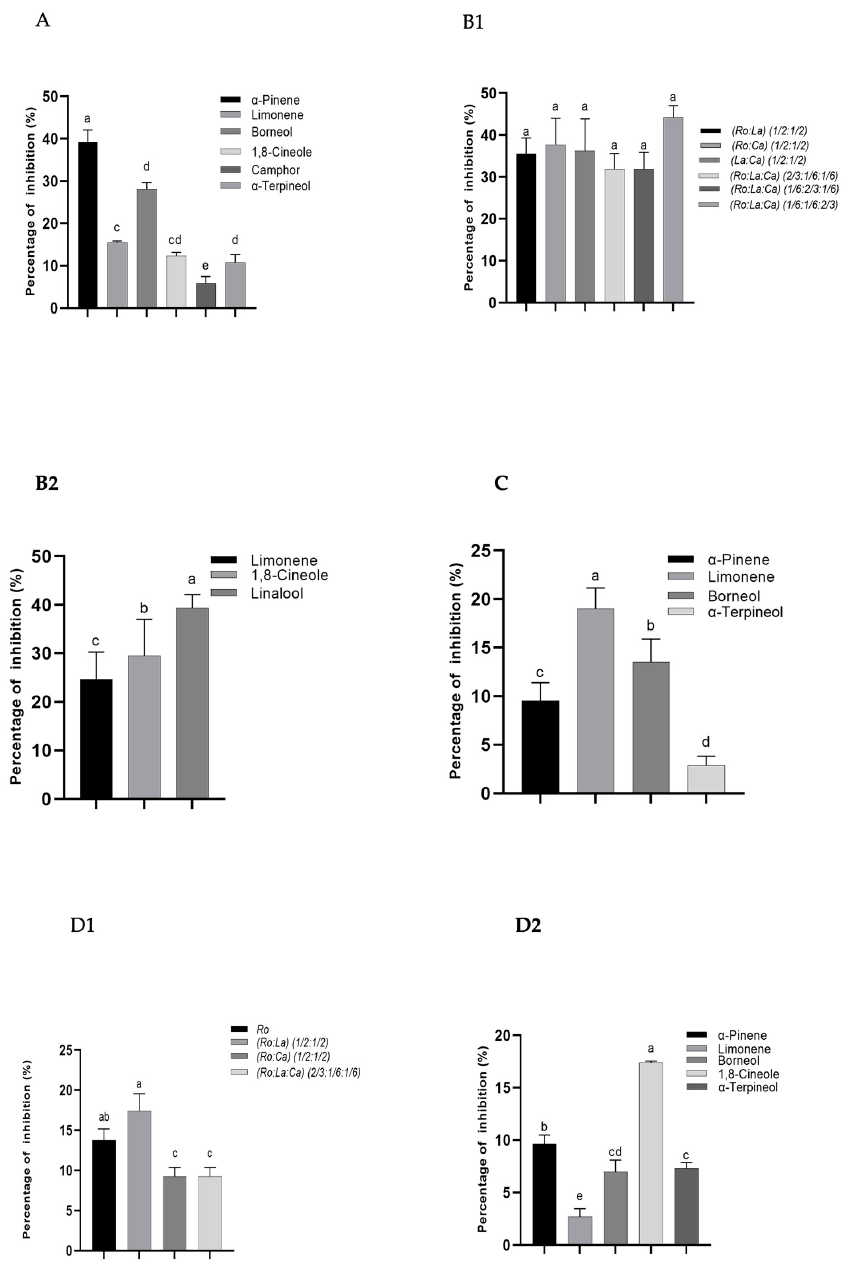
Figure 3. Antioxidant activities. ( A ) Percentage of 2,2-diphenyl-1-picrylhydrazyl (DPPH) free radical-scavenging activity of the major components: α -pinene (215 mg/mL), limonene (4 mg/mL), borneol (4 mg/mL), 1,8-cineole (231 mg/mL), camphor (500 mg/mL), α -terpineol (209 mg/mL), ( B1 ) Percentage of H 2 O 2 inhibition for Ro (45 mg/mL) , La (42 mg/mL) , Ca (42 mg/mL) , ( Ro:La) (46 mg/mL) , ( Ro:Ca ) (43 mg/mL), ( La:Ca ) (46 mg/mL), ( Ro:La:Ca ) (1:1:1) (42 mg/mL), ( Ro:La:Ca ) (2/3:1/6:1/6) (43 mg/mL), ( Ro:La:Ca ) (1/6:2/3:1/6) (42 mg/mL), ( Ro:La:Ca ) (1/6:1/6:2/3) (42 mg/mL), ( B2 ) Percentage of H 2 O 2 scavenging of the major components (limonene (4 mg/mL), 1,8-cineole (5 mg/mL), linalool (4 mg/mL), ( C ) Percentage of nitric oxide free radical-scavenging of the major volatiles α -pinene (9 mg/mL), limonene (4 mg/mL), borneol (4 mg/mL), α -terpineol (5 mg/mL), ( D1 ) Percentage of superoxide anion scavenging for Ro (15 mg/mL), ( Ro:La ) (8 mg/mL), ( Ro:Ca) (7 mg/mL), and ( Ro:La:Ca ) (2/3:1/6:1/6) (15 mg/mL); ( D2 ) Percentage of superoxide anion scavenging of the major components α -pinene (1 mg/mL), limonene (8 mg/mL), borneol (8 mg/mL), 1,8-cienole (8 mg/mL), α -terpineol (8 mg/mL). Bars represent standard deviations (n = 3). Values with the same letter are not significantly different ( p > 0.05) by Tukey’s multiple range Molecules 2021 , 26 , 5452. https://doi.org/10.3390/molecules26185452